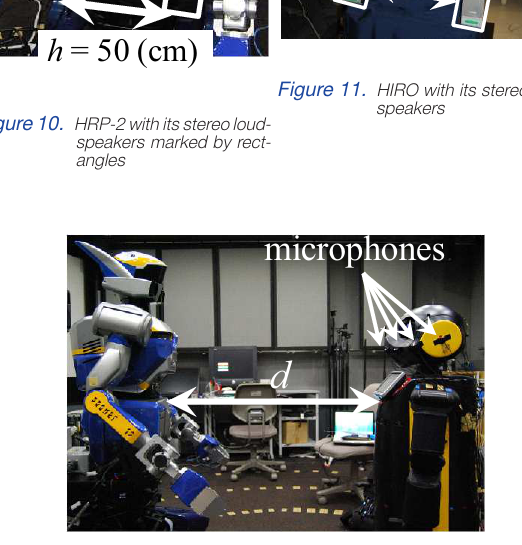
Figure 12. HRP-2 on the left and Robovie-R2 on the